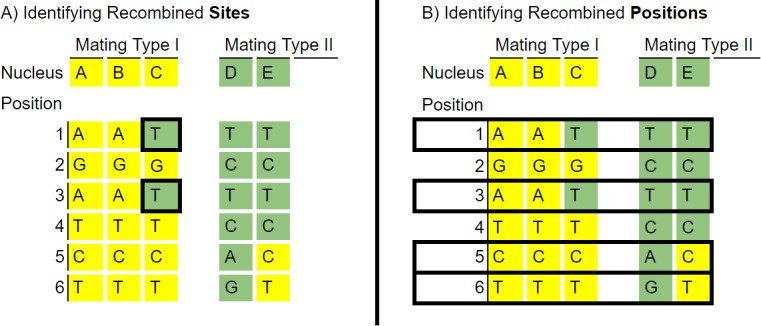
Example of the two criteria used to identify recombination.To identify individual recombined sites, a parsimony criterion, used for Figure 2B was applied as seen in A), where the recombined nucleus was determined based on the majority genotype for a given mating type. Note that positions 5 and 6 for nucleus E are not identified as there is one nucleus of mating type II with each genotype, this criterion cannot identify sites when there are equal number of nuclei of a mating type with each genotype. To more fully identify recombination positions, we also used a criterion of a difference in genotype between nuclei of the same mating type. This criterion is capable of identify examples such as position 5 and 6, but does not identify which sites are recombined.